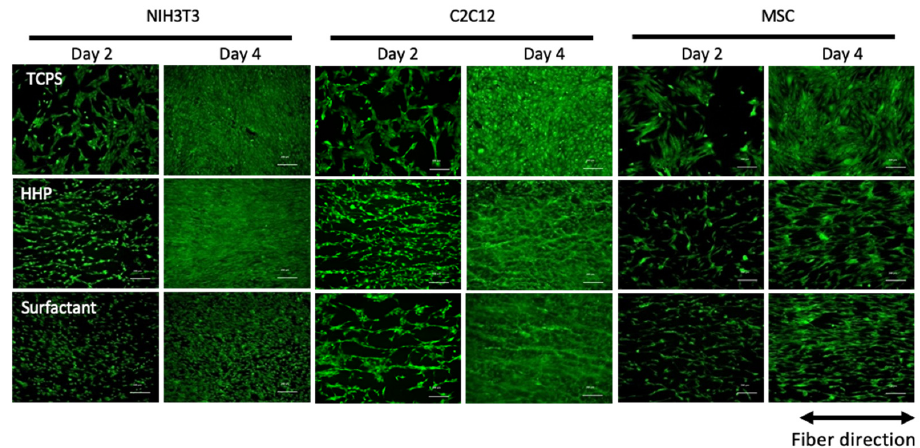
Figure 6. Fluorescent microscopy observation of various types of cells seeded on TCPS, HHP-decel- lularized pericardium, and surfactant-decellularized pericardium. The cells were stained with Cal- cein-AM, which shows living cells. Scale bar: 200 µm.